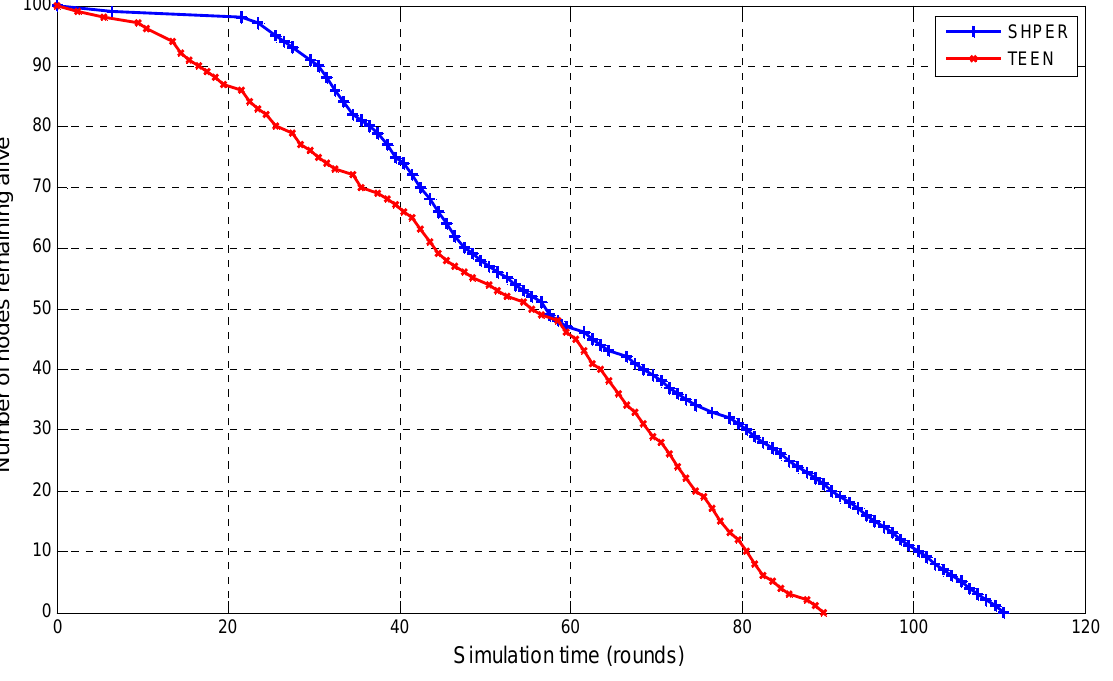
Figure 11. Comparative depiction of the nodes remaining alive over the simulation time steps in SHPER and TEEN [ Er (0)  [0.1,0.5] J, D = 200 m]. i